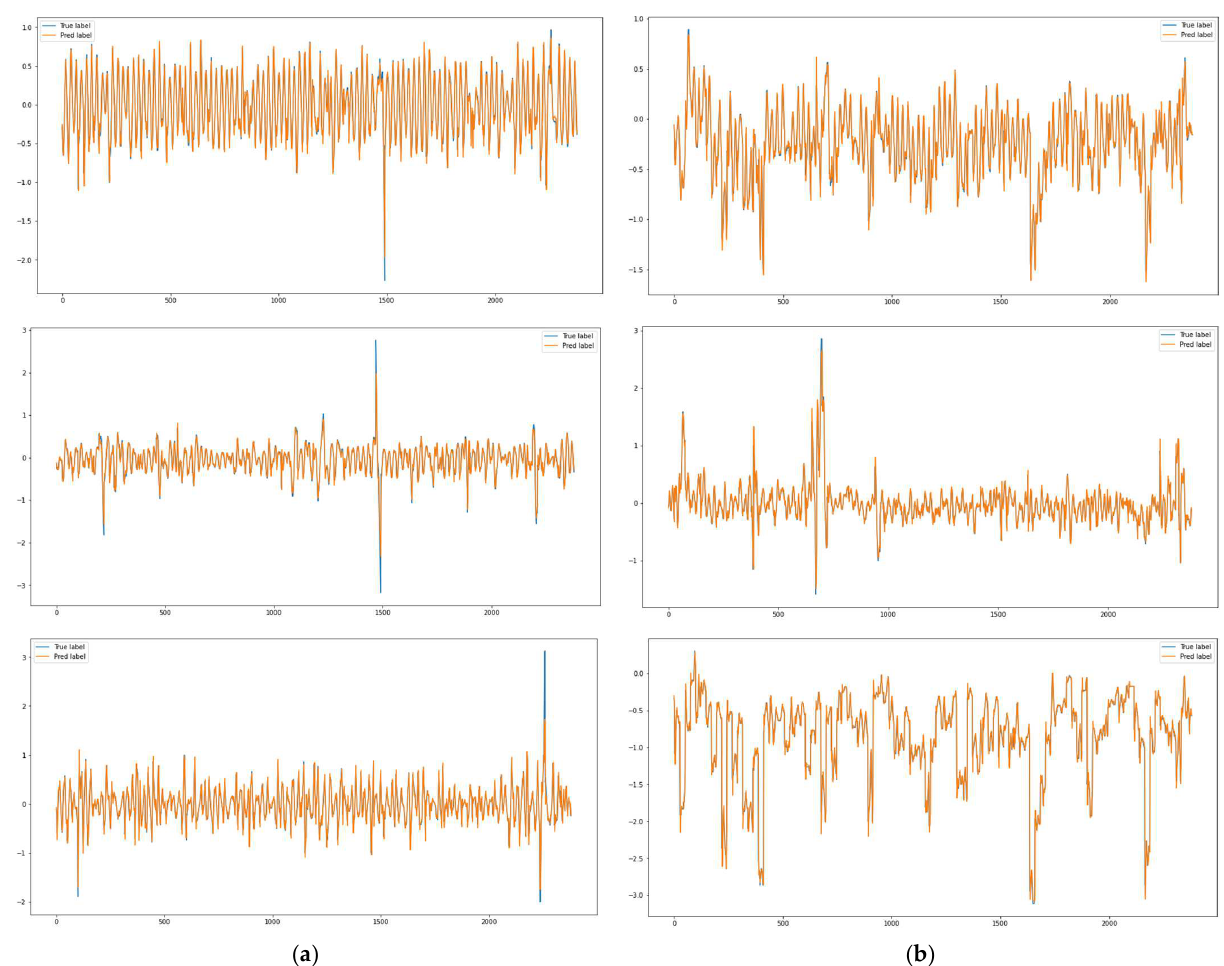
, , and in Beijing ( a ) and Shanghai ( b ). (cid:16) (cid:11)X3 (cid:16) (cid:13)dc (cid:16) (cid:13)(cid:11)